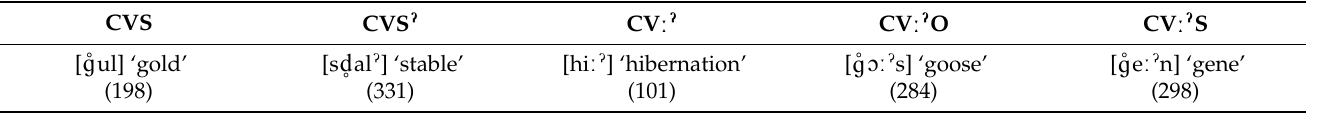
Table 4. Stimuli by word type. The total number of tokens per word type included in the final study is given in parentheses below the example (total =